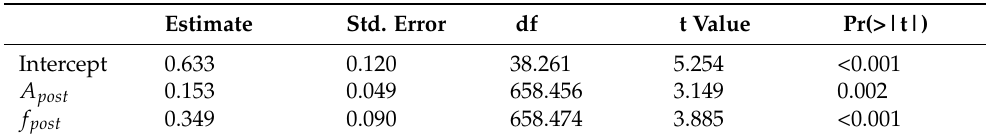
Table 2. Estimates for main effects of a mixed linear model predicting the magnitude of the eyebrow peak based on the parameters of the sinusoidal function for the post-peak region, with a window size of 17 frames ( ≈ 570 ms). Estimate Std. Error